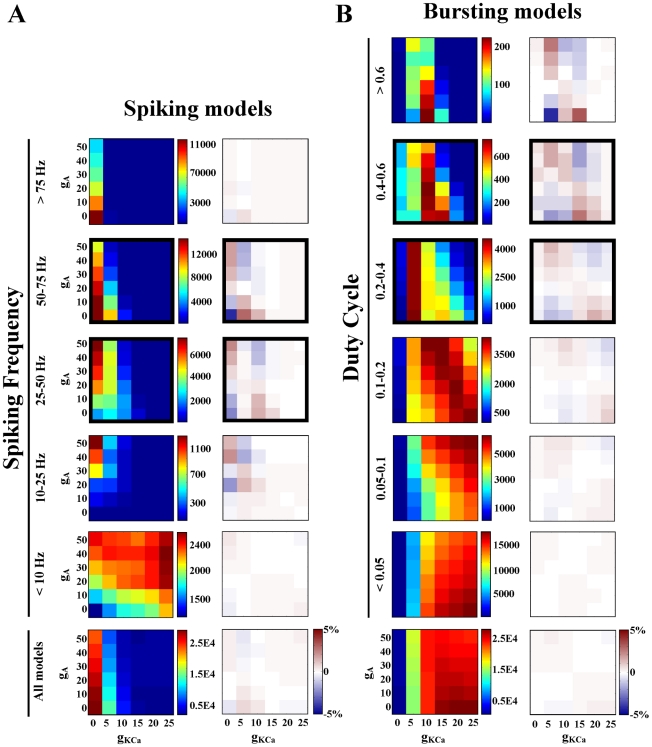
Values of gA and gKCa are correlated for spiking models with a frequency between 25 and 75 Hz and bursting models with duty cycle between 0.2 and 0.6.Spiking models are represented by the leftmost two columns (A), and bursting models are shown to the right (B). Frequency or duty cycle range is specified to the left of each pair of plots, excluding the bottom row which represents all spiking or bursting models. Bold black borders indicate a correlation (χ2>500 and |ρ|>0.2). The gA and gKCa relationship in bursting models with duty cycle >0.6 (top right) was considered a false negative result (χ2 = 262, ρ = −0.33).